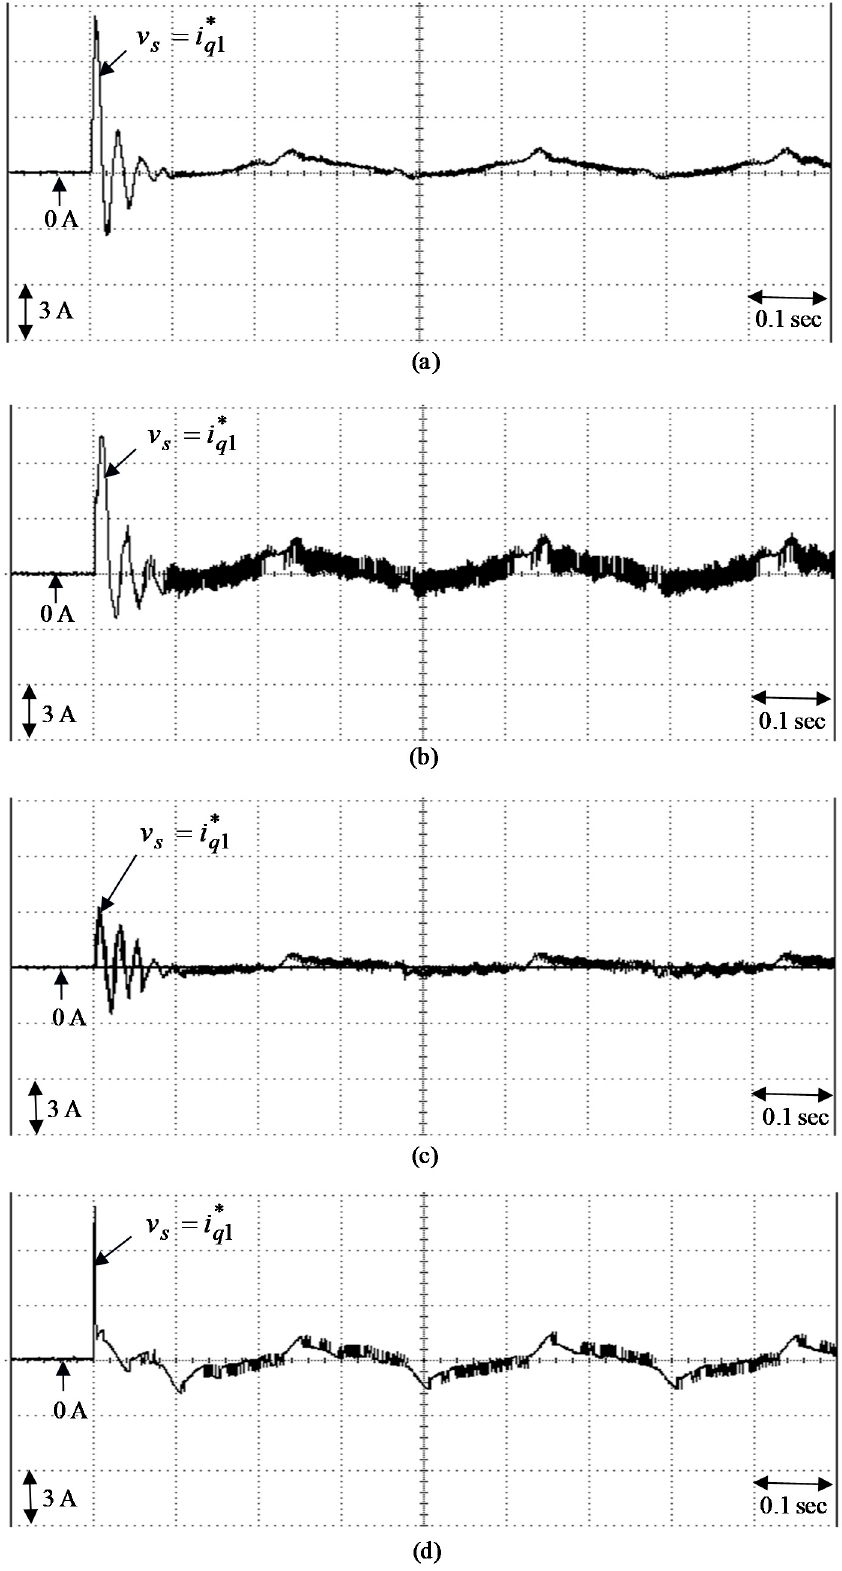
Figure 15. Experimental results of the response of control propulsion in Case R4 ( a ) by utilizing control system W1, ( b ) W2, ( c ) W3, and ( d ) W4.